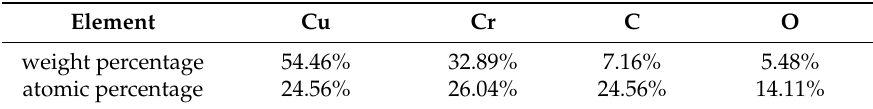
Table 5. Solidification component inside shield detected by